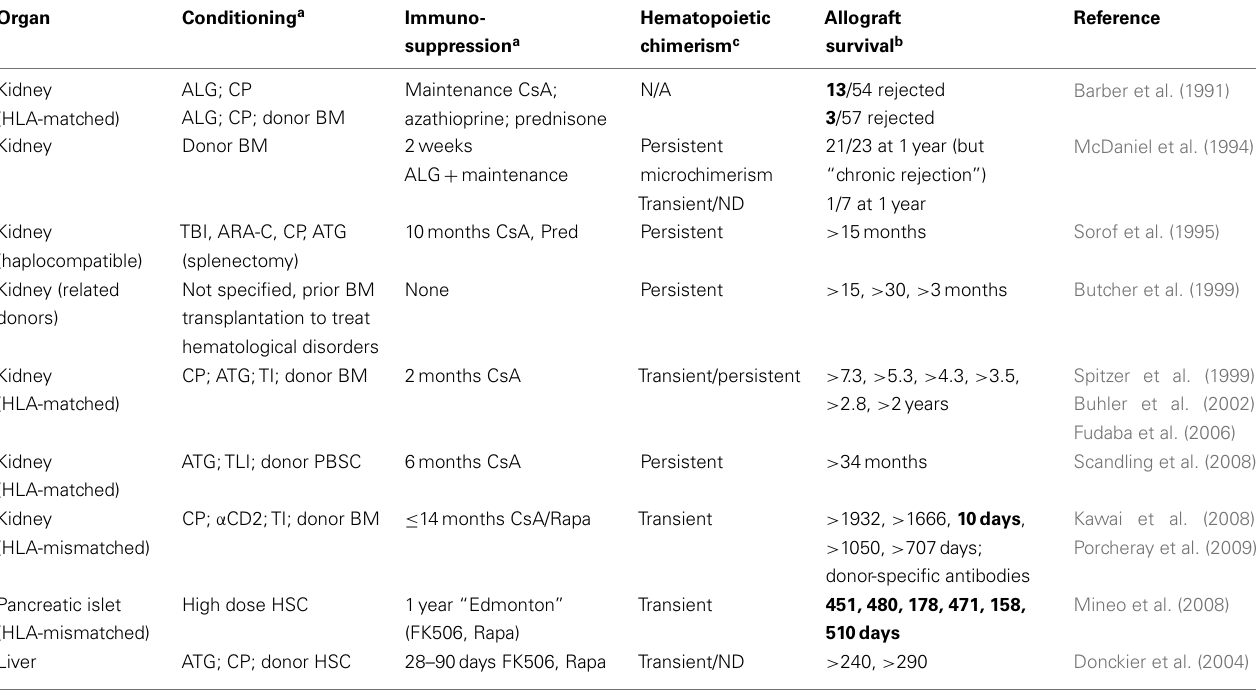
Table 3 | Combined bone-marrow and organ transplantation in